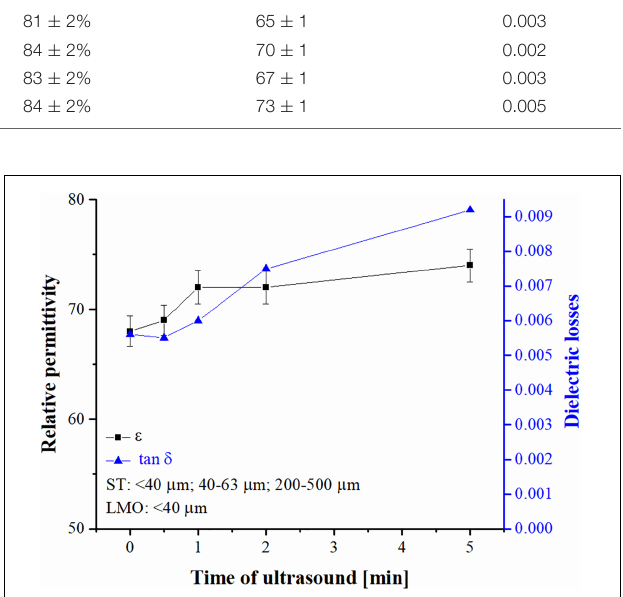
FIGURE 5 | The effect of ultrasound duration on the dielectric properties of LMO-ST composites fabricated at